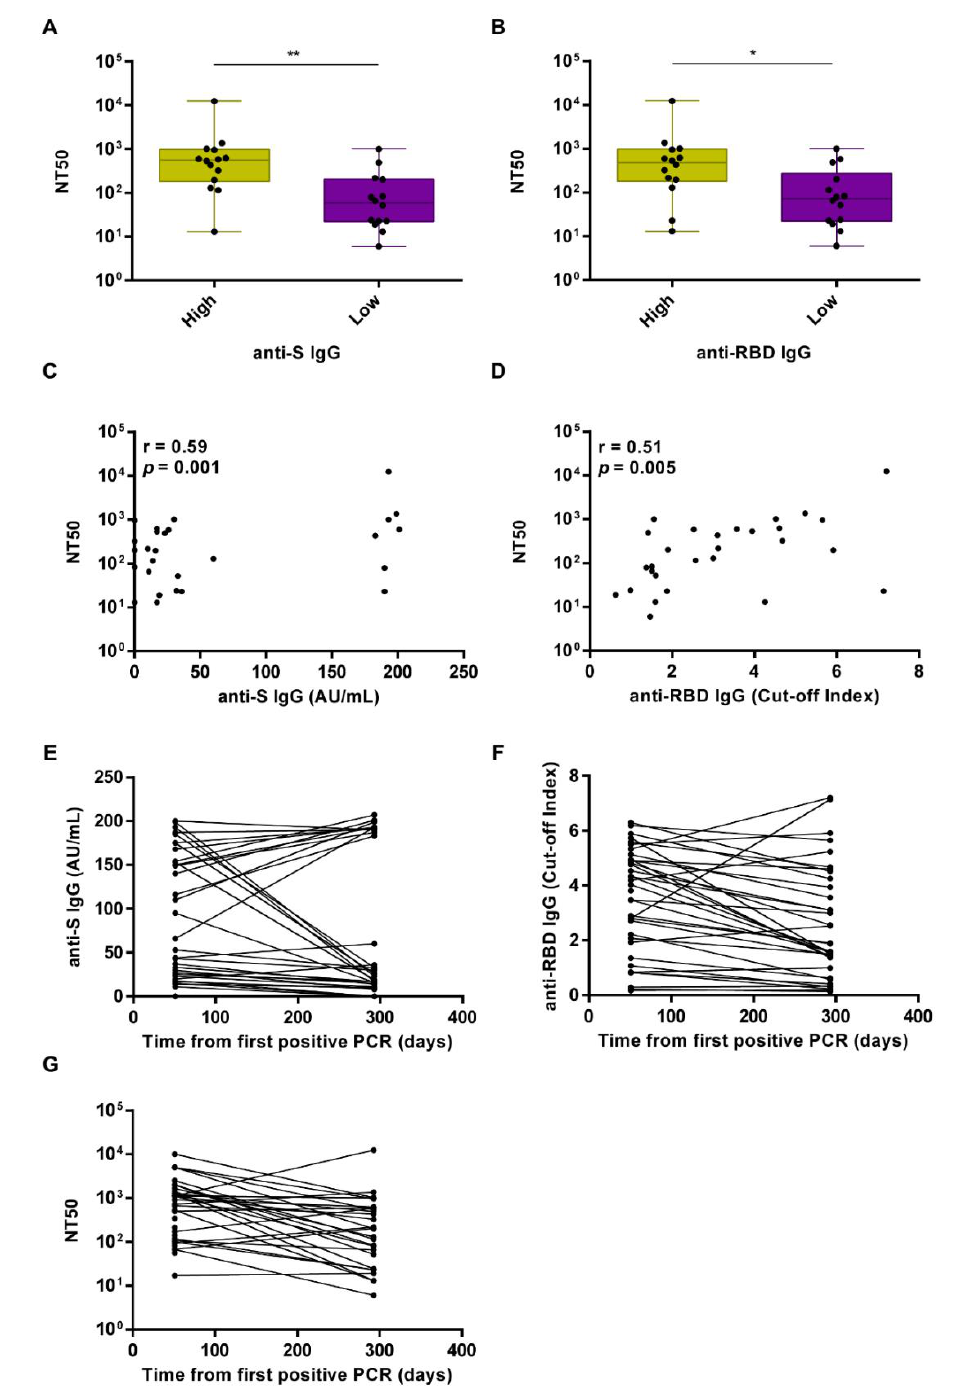
Figure 4. Longitudinal analysis of the neutralizing activity at 10 months (M10) after the first positive PCR test. ( A ) Box plot distribution of the neutralizing activity expressed as NT50 in the group of high or low anti-S IgG levels—above and below the median, respectively. Comparative analysis was performed by Mann-Whitney test. ** p < 0.01. ( B ) Box plot distribution of the neutralizing activity expressed as NT50 in the group of high or low anti-RBD IgG levels—above and below the median, respectively. Comparative analysis was performed by Mann-Whitney test. * p < 0.05. Solid circles indicate individual values. ( C ) Spearman correlation between anti-S IgG AU/mL and the neutralizing activity expressed as NT50 at M10. ( D ) Spearman correlation between anti-RBD IgG cut-off index and the neutralizing activity expressed as NT50 at M10. ( E ) Longitudinal mapping of anti-RBD IgG cut-off index, anti-S IgG AU/mL ( F ), or neutralizing activity expressed as NT50 ( G ) in seropositive unvaccinated subjects (n = 28) at M2 and M10 after the first PCR-positive